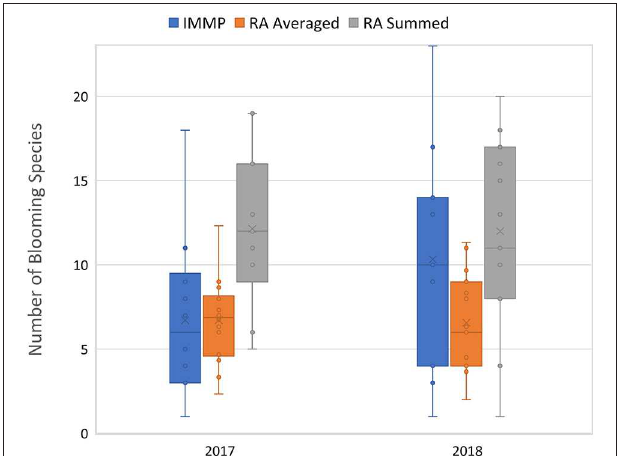
FIGURE 6 | Mean number of blooming species as estimated by the Integrated Monarch Monitoring Program (IMMP), averaging across Rapid Assessments (RA averaged) per IMMP site, and summing across Rapid Assessment (RA summed) per IMMP site. Number of species did not differ by protocol type ( t 82 = − 0.047; p = 0.963) but there was an effect of year ( t 27 = 2.33, p = 0.027) and protocol type by year interaction ( t 82 = − 2.86; p = 0.005). Mean values are indicated by the “x”; median values by a horizontal line, boxes indicate 25 and 75% quartiles, and bars indicate the upper and lower quartiles.